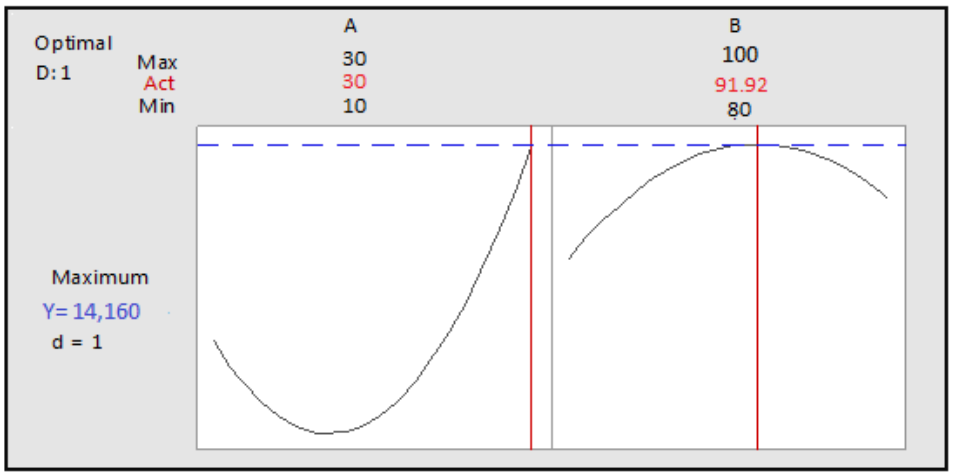
Figure 8. Optimization of the two cooking time and temperature factors as a function of desirability; A: Cooking time; B: Cooking temperature.